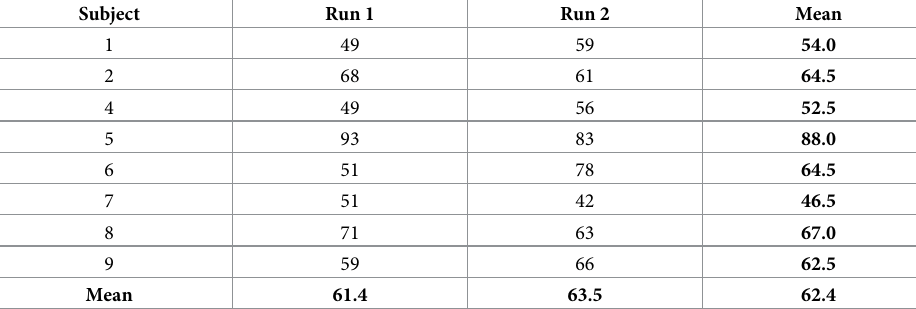
Table 1. Online classification accuracies (percent) when delivering visual feedback (Data